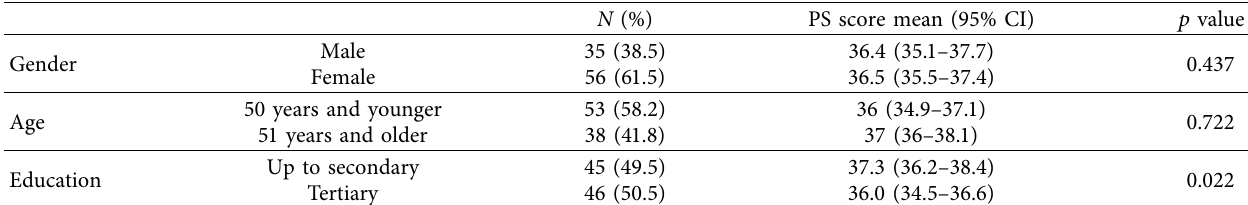
Table 2: Association between patient’s gender, age, and education level with their satisfaction scores. N (%)